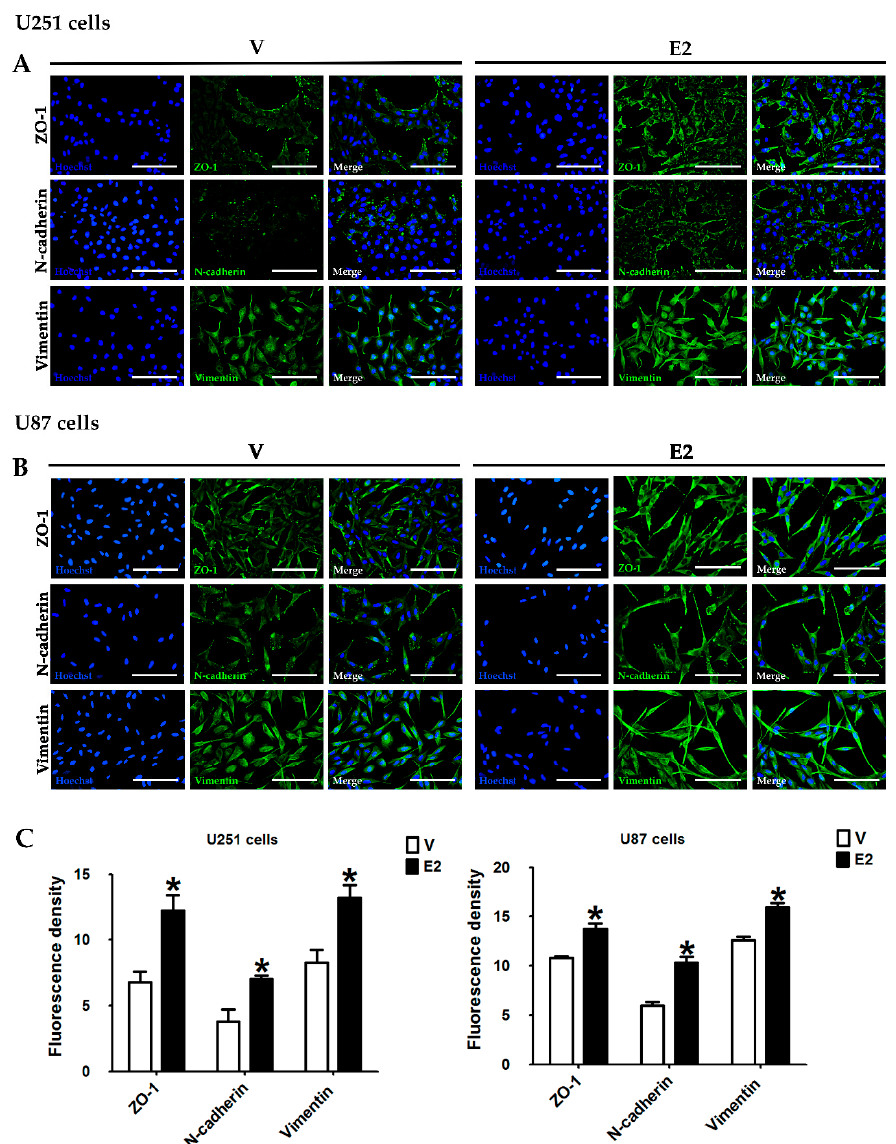
Figure 5. E2 modified EMT marker distribution and immunoreactivity in human GBM-derived cells. ZO-1, N-cadherin, and vimentin immunostaining in ( A ) U251 and ( B ) U87 cells treated with 17 β -estradiol (E2, 10 nM) and vehicle (V, 0.01% cyclodextrin) for 48 h. Representative images were captured under a fluorescence microscope at a magnification of 400×. ( C ) EMT marker expression measured as a fluorescence density. Results are expressed as the mean ± standard error of the mean (SEM); n = 3; * p < 0.05 vs. V.